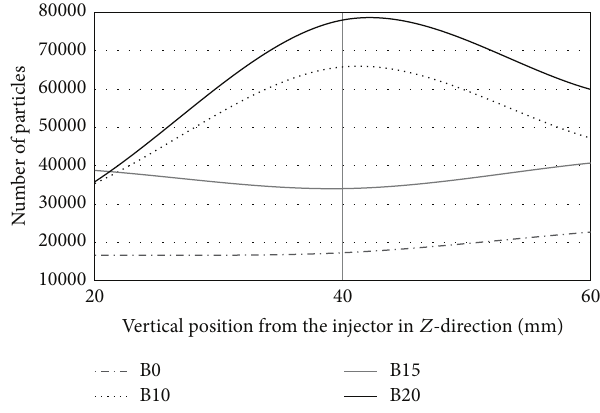
Figure 19: Number of spray particles for different HFO/n-butanol blendsatinjectionpressureof1000 barondifferentverticalpositions from the injector.